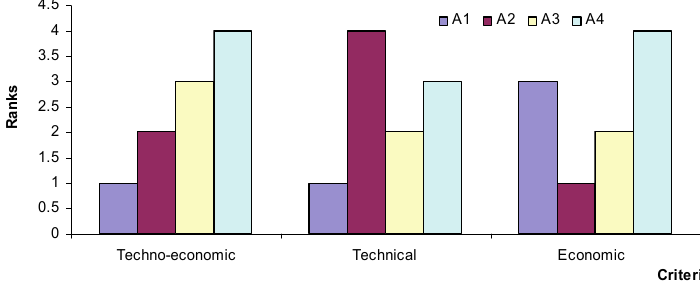
Fig. 1. Performance of the light